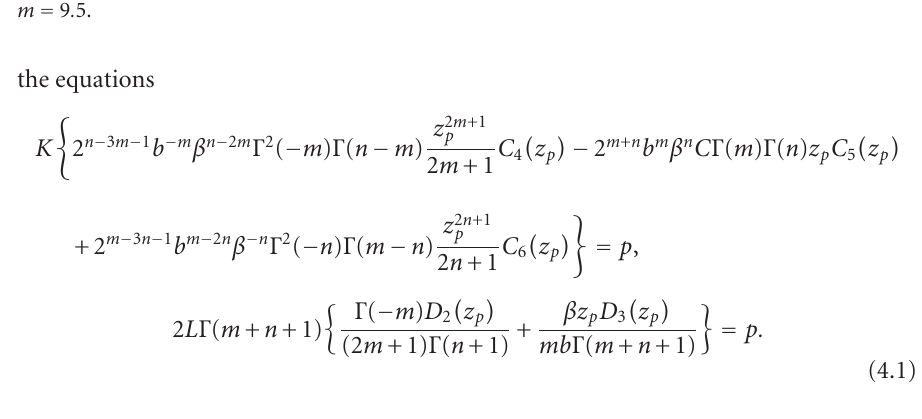
Figure 4.1. Plots of the pdf (3.1) for b = 1, β = 1, and (a) m = 1 . 5; (b) m = 2 . 5; (c) m = 4 . 5; and (d) m = 9 .